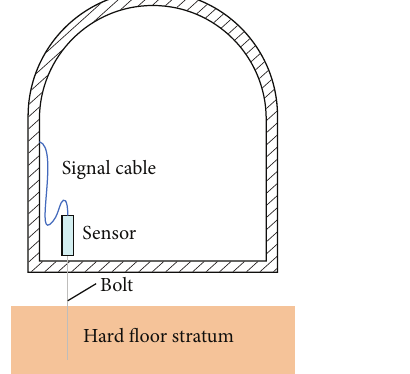
Figure 2: Installation of sensors.